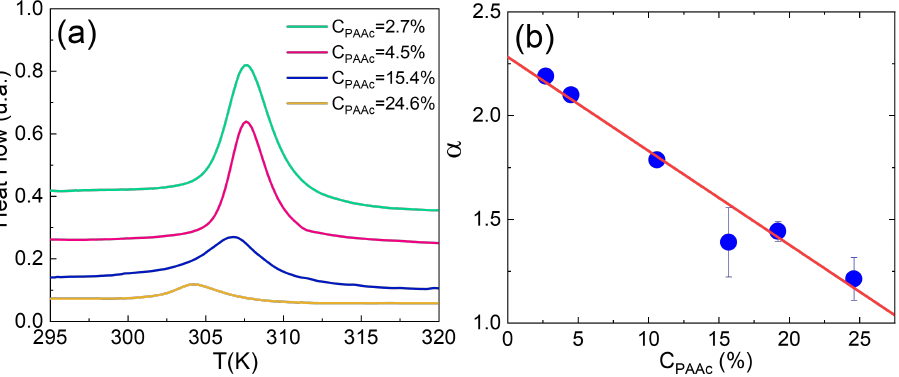
Figure 7. ( a ) DSC thermograms for IPN microgels with different PAAc contents at C w = 10.0%, pH 5.5 and at heating rate of 10 K/min. ( b ) Swelling ratio from Equation (3) for IPN microgels at different PAAc